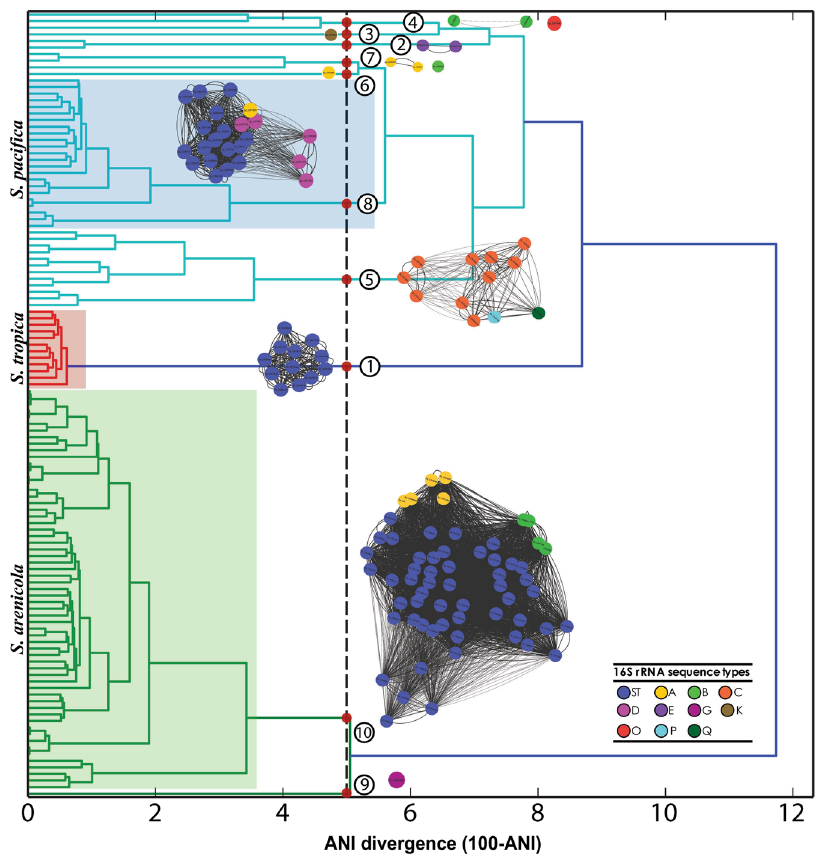
Figure 4. Average Nucleotide Identity (ANI) distance matrix. The vertical dashed line represents 95% ANI. Strains associated with the three primary clades are delineated by green ( S . arenicola ), red ( S . tropica ), and light blue ( S . pacifica ) branches. ANI clades that share > 95% and are associated with type strains are shaded. Red circles and corresponding numbers represent all lineages that share < 95% ANI values including seven (2–7, 9) that do not contain type strains. ANI-AF networks are shown adjacent to the corresponding regions in the dendogram. Each node represents a strain and is color-coded based on the 16S rRNA gene sequence types (single nucleotide polymorphisms) observed for each